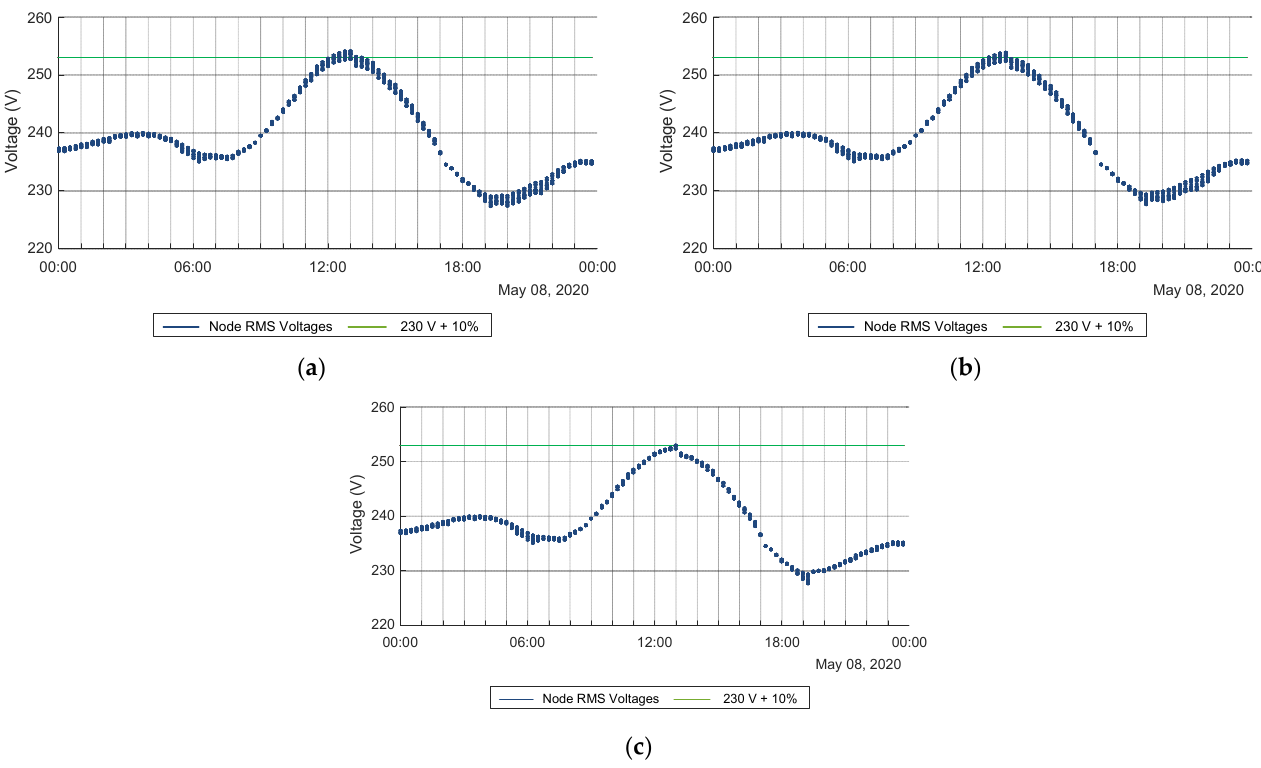
Figure 14. Swarm plot of the node phase voltages in REC 1 at 15-min intervals throughout the day. The green line represents the 230 V + 10% maximum limit (line-to-neutral). Each point is a resultant phase voltage at one of the nodes in the LV network. ( a ) No communal storage. ( b ) Communal storage placed at start of REC. ( c ) Communal Storage placed at the end of the REC.